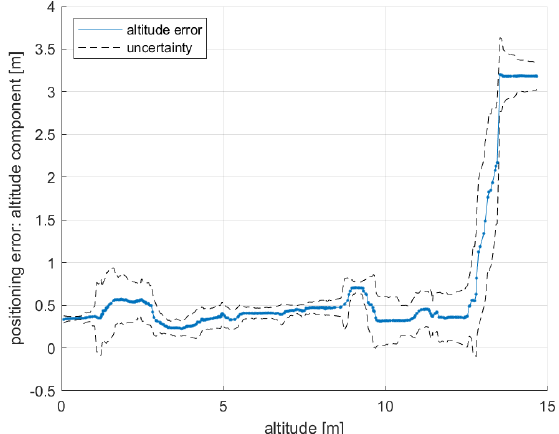
Figure 8. Height component of the positioning error varying the drone altitude.